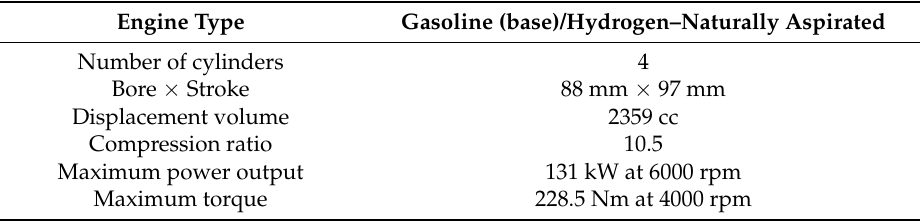
Table 1. Engine specifications.